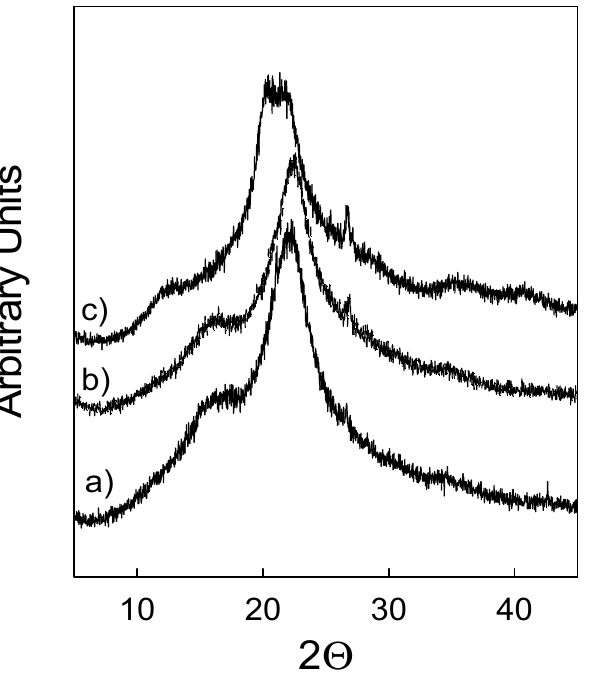
Figure 9. Powder XRD patterns of: ( a ) native wheat straw, ( b ) pre-treated with [emim][HSO 4 ], and ( c ) pre-treated with [emim][OAc] IL.